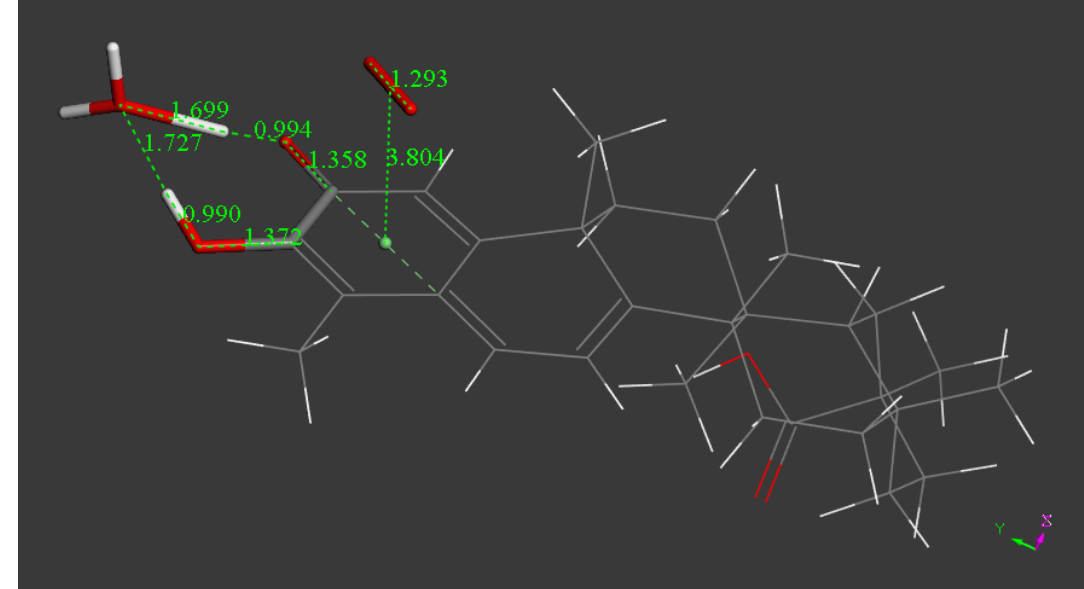
Figure 10. Geometry optimization of the complete celastrol molecule. When superoxide is π stacked on the celastrol quinoid ring, an electron is captured by the latter. Later, an H 3 O + approach to the ring carbonyl induces proton capture, d[(C=O)-H] = 0.994 Å , plus water formation. Total charge of this semiquinone species is zero due to the charged negative superoxide (−1) plus the H 3 O + charge.